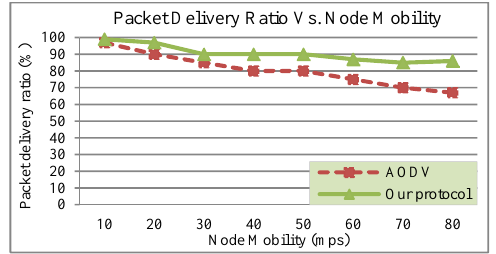
Fig. 6. Packet Delivery Ratio Vs. Node Mobility